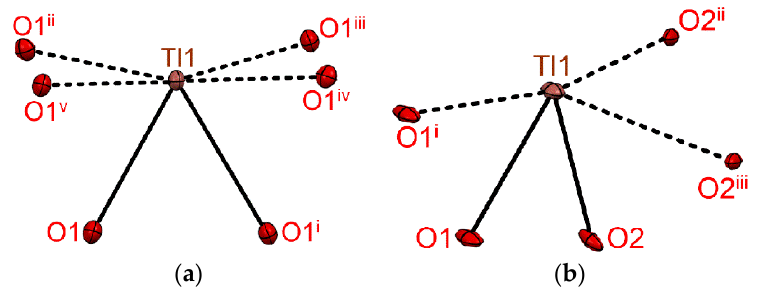
Figure 4. Coordination spheres of thallium(I) ions in complexes: ( a ) 1 and ( b ) 2 (symmetry codes as in Table 2). Solid and dashed lines indicate chelating bonds and intermolecular contacts, respectively.